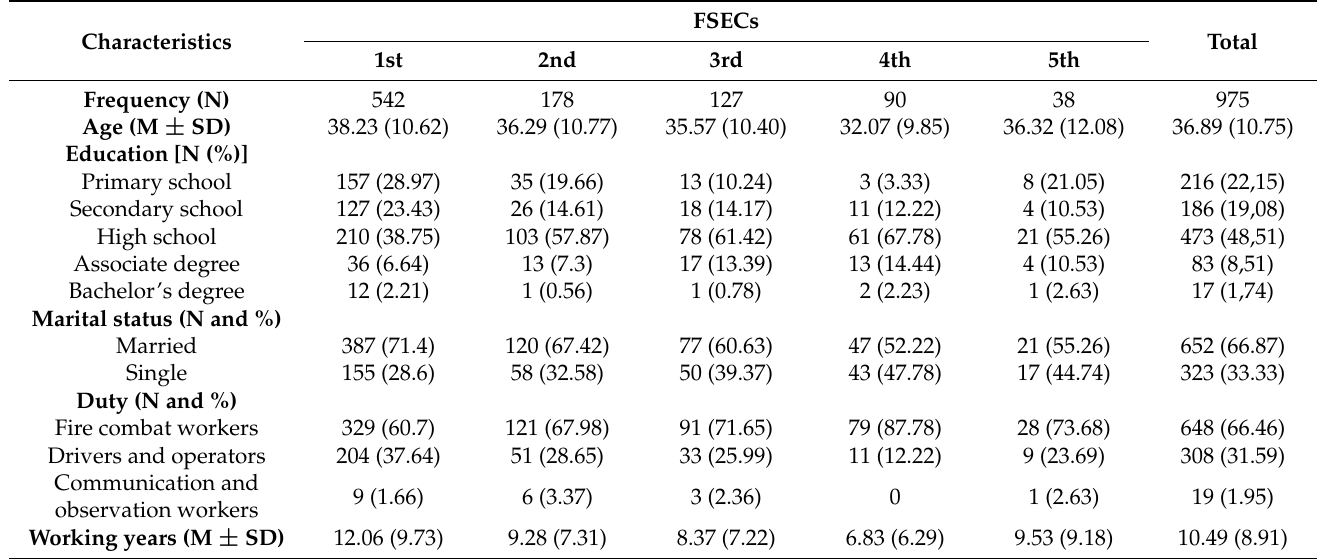
Table 3. Descriptive statistics of the five questionnaire